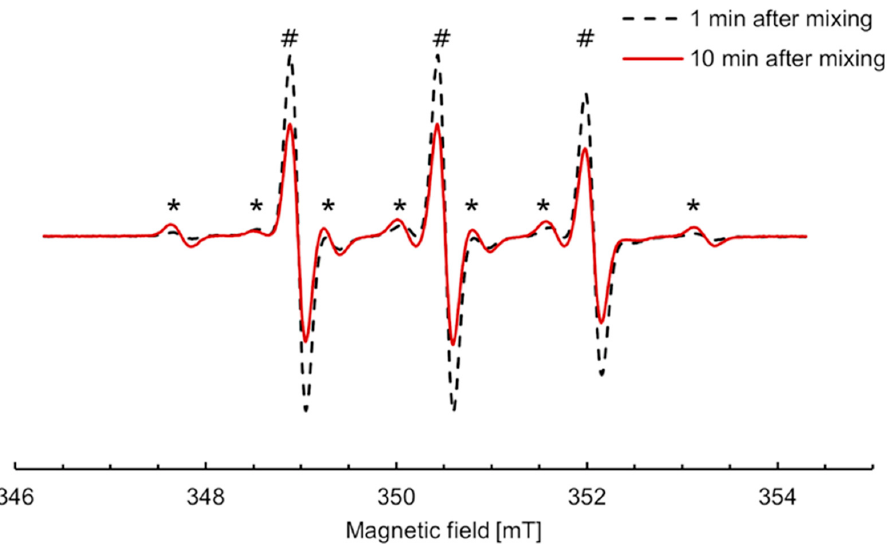
Figure 5. EPR spectra of nitroxide 5 (300 μ M) incubated with RLM (30 μ M P450) supplemented with NADPH (2 mM) in potassium phosphate buffer (0.1 M, pH 7.4, containing 1 mM DTPA) in the presence of oxygen at 21 °C, 1 min (black dash) and 10 min (red line) after mixing, respectively. The intensity of the new six-line species (*) increased concomitantly to the decrease in the three lines characteristic of nitroxide 5 (#).